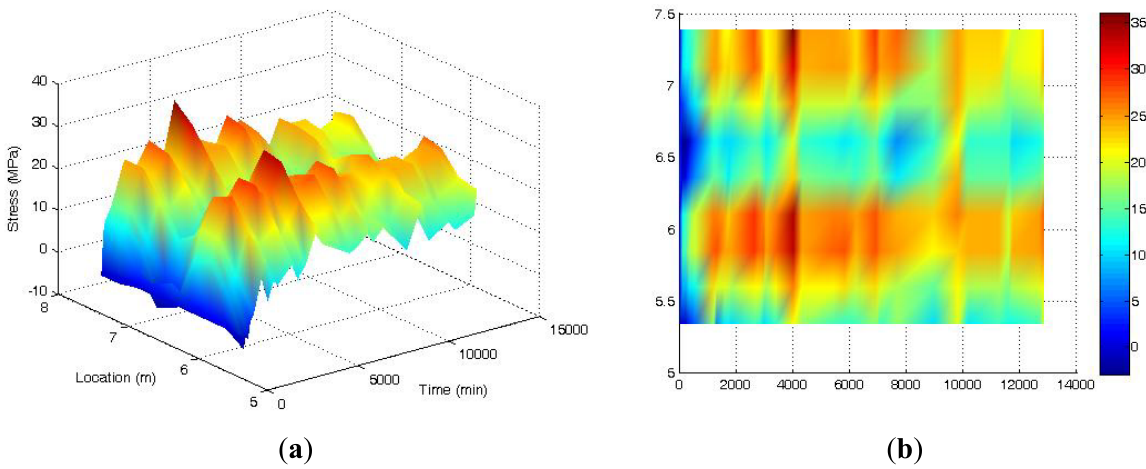
Figure 14. Prestress losses of prestressed beam at normal service limit state measured by BOTDA sensor in the smart strand. ( a ) Three-dimension graph; and ( b ) Stress nephogram.